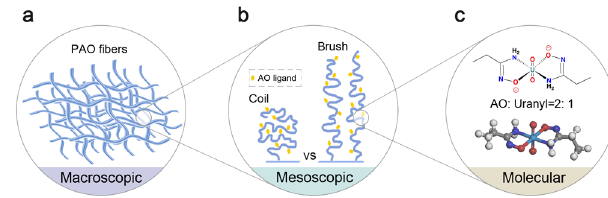
Fig. 1 Schematic illustration of factors in fl uencing uranium adsorption by PAO. a Morphology of PAO fi bers at the macroscopic level. b Spatial conformations of PAO chains at the mesoscopic level. c Metal-ligand interaction at the molecular